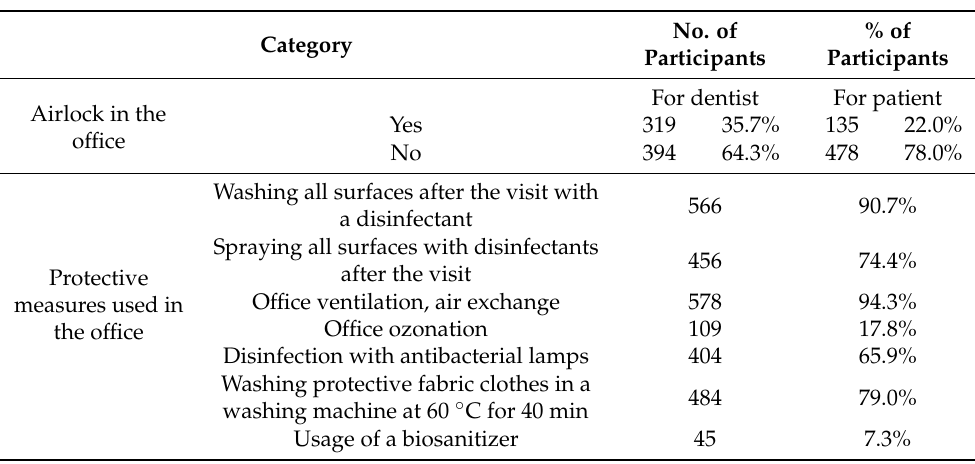
Table 5. Protective measures used in the office taken by dentists that continued to work after the